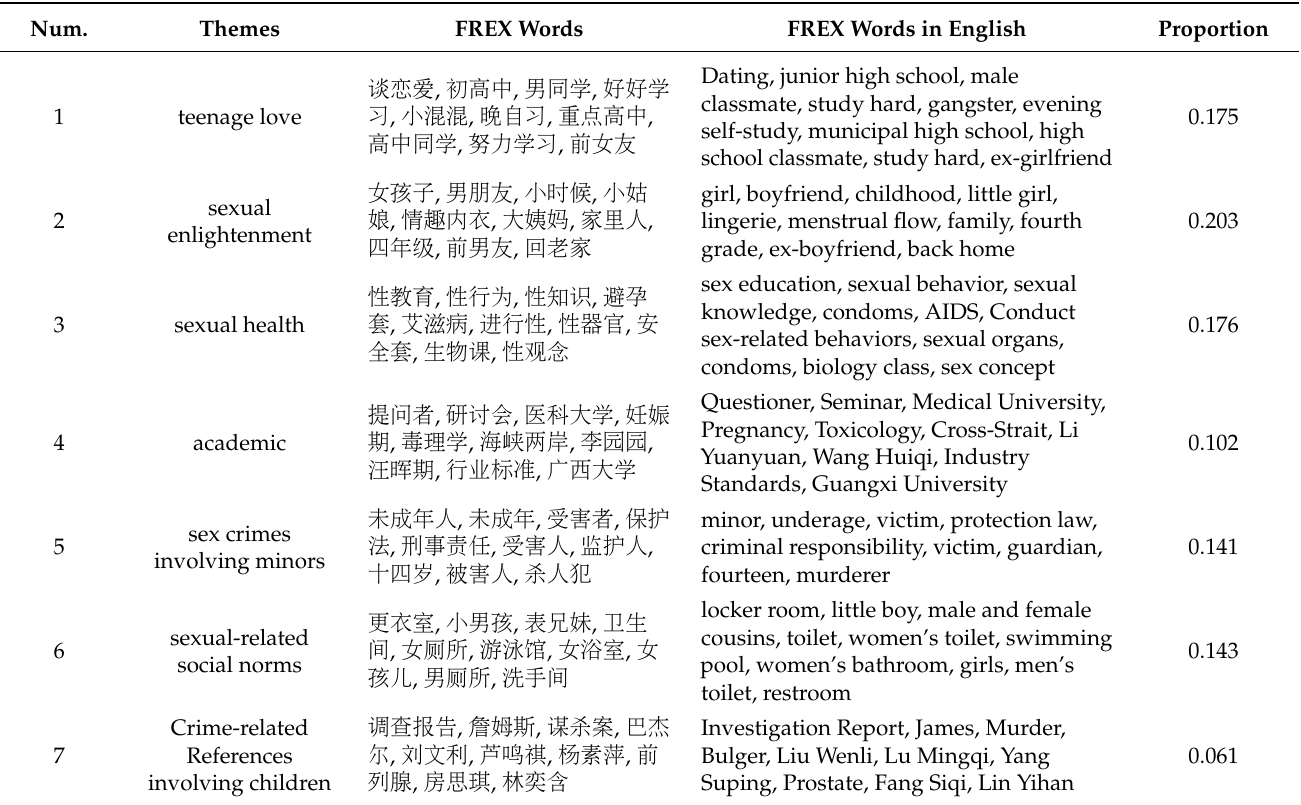
Table 2. Themes and FREX words produced by the STM model.